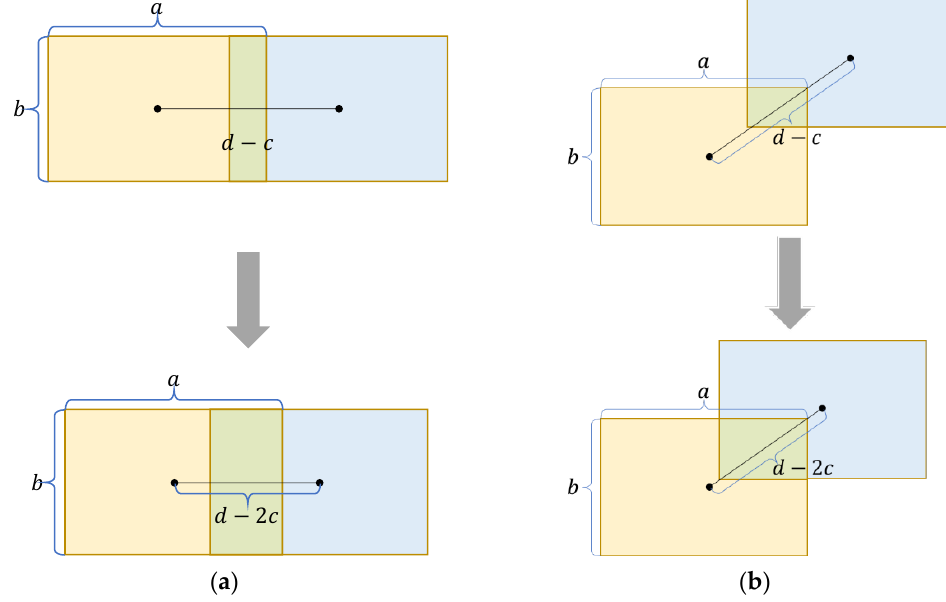
Figure 4. The yellow box refers to the ground-truth box, the blue box refers to the predicted box, the green box refers to the area where two boxes coincide. ( a ) The predicted box converges along the x -axis direction to the ground-truth box; ( b ) the predicted box converges along the diagonal direction of the ground-truth box to the ground-truth box.